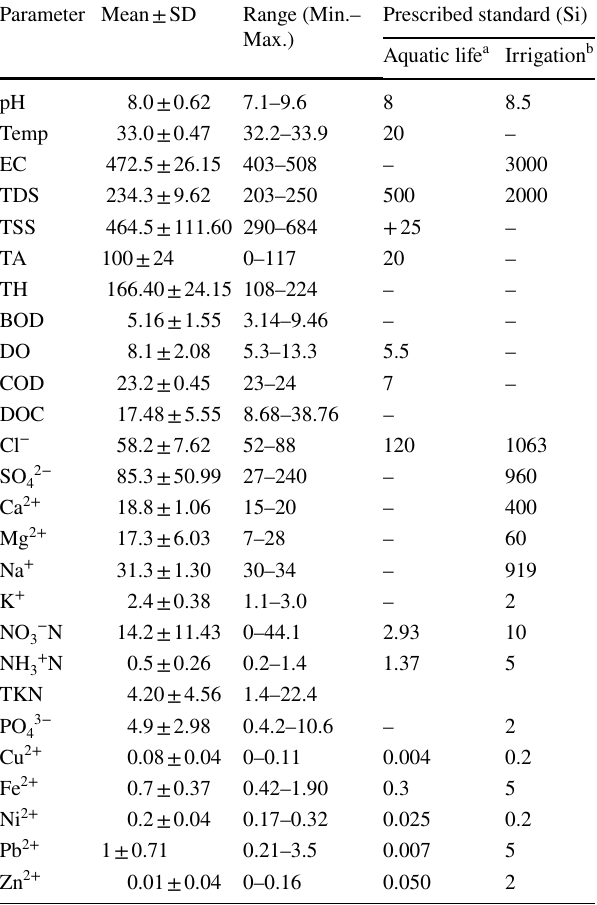
Table 1 Average concentration of physico-chemical characteristics of water samples collected from Bhindawas wetland